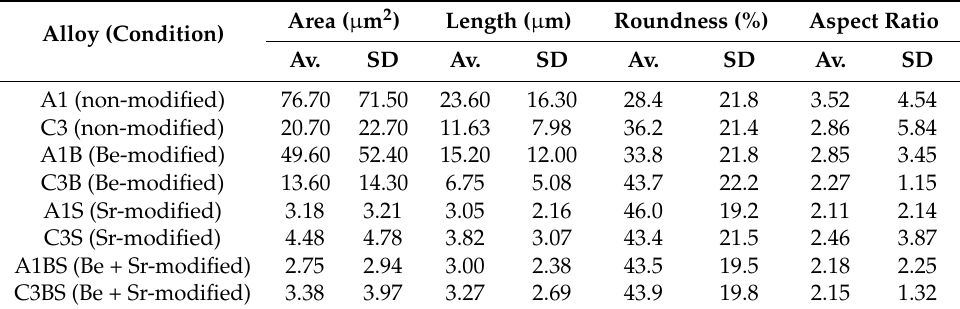
Table 3. Silicon particle measurements for the as-cast 357 alloys using a graphite mold with a DAS of 65 µ m.